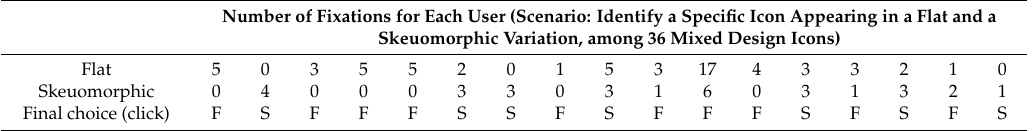
Table 9. Number of fixations on the two icon versions (flat or skeuomorphic) and final choice (F/S) for each user 2